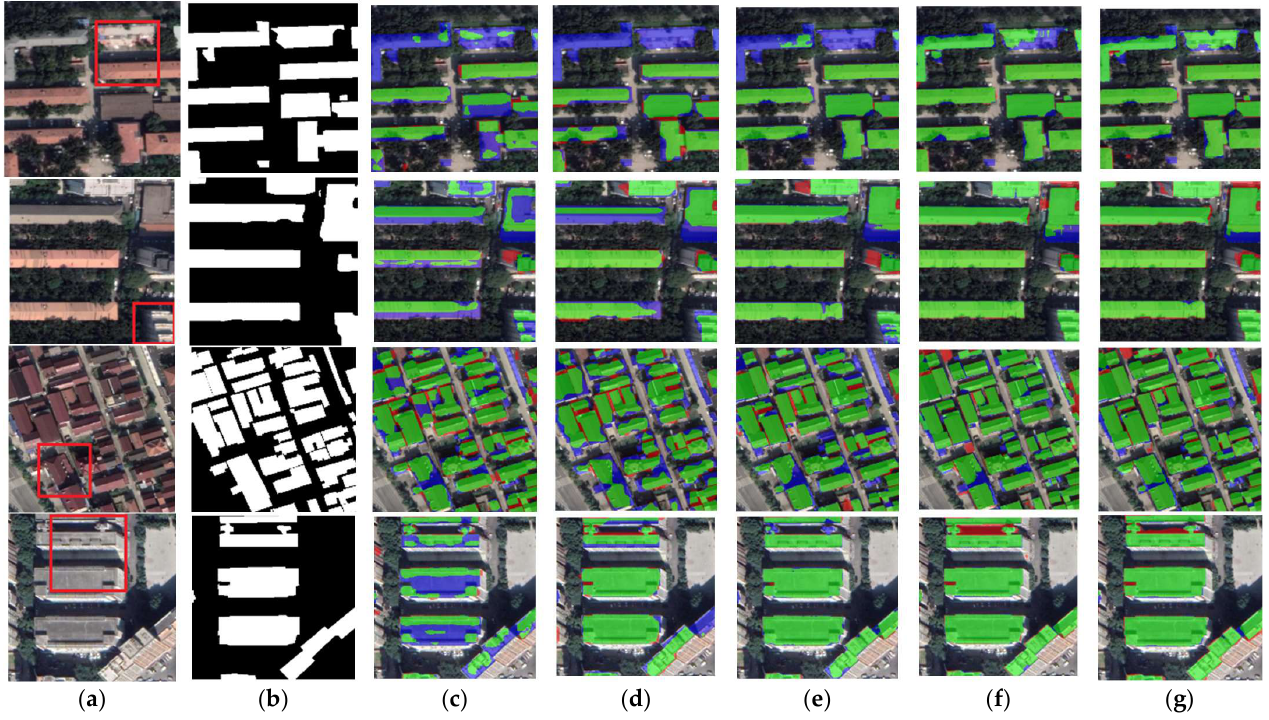
Figure 10. Examples of building extraction results obtained by different networks on the CHN dataset. ( a ) Original image. ( b ) Ground-truth. ( c ) FCN8s. ( d ) DANet. ( e ) SegNet. ( f ) U-Net. ( g ) BGC-Net. Note, in Columns ( b – g ), black, white, green, blue, and red indicate true, false, true-positive, false-negative, and false-positive, respectively. The red rectangles in ( a ) are the selected regions for close-up inspection in Figure 10.